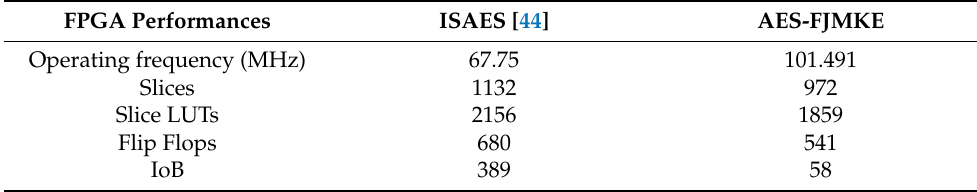
Table 11. Comparison of AES-FJMKE and ISAES for Spartan 3.